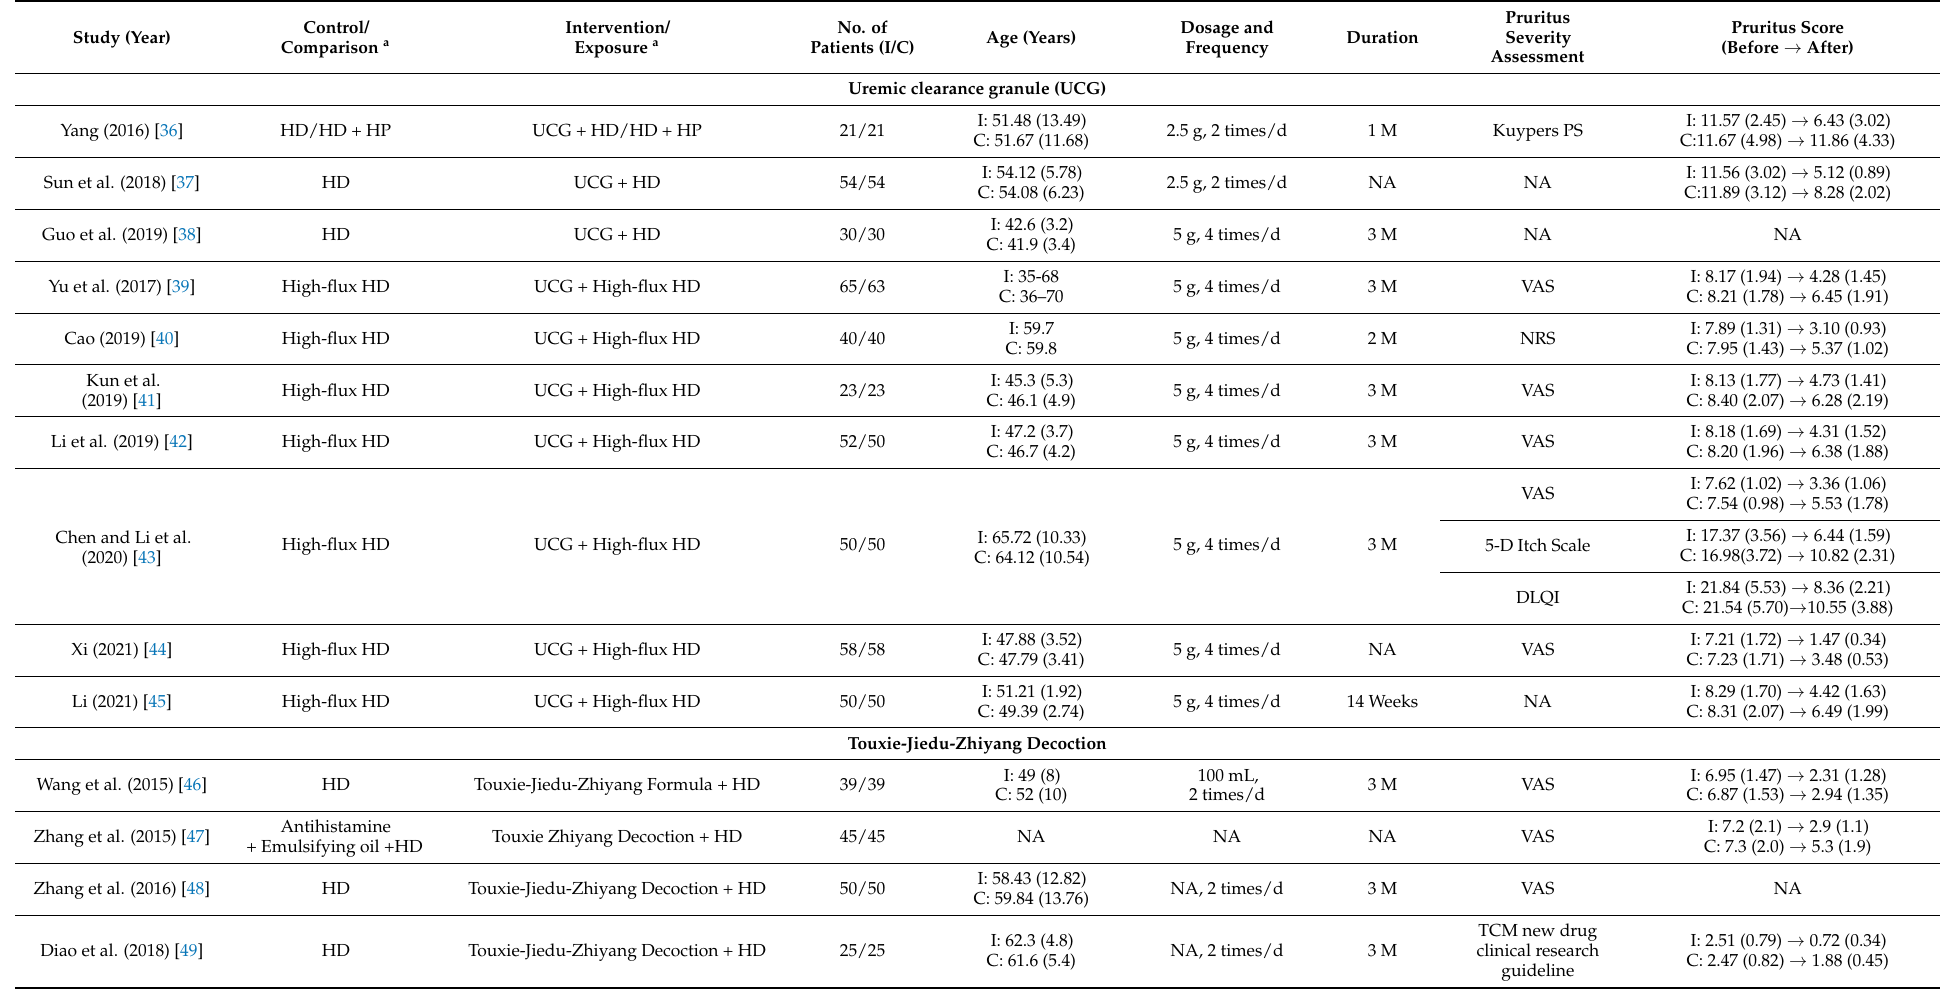
Table 1. Characteristics of selected